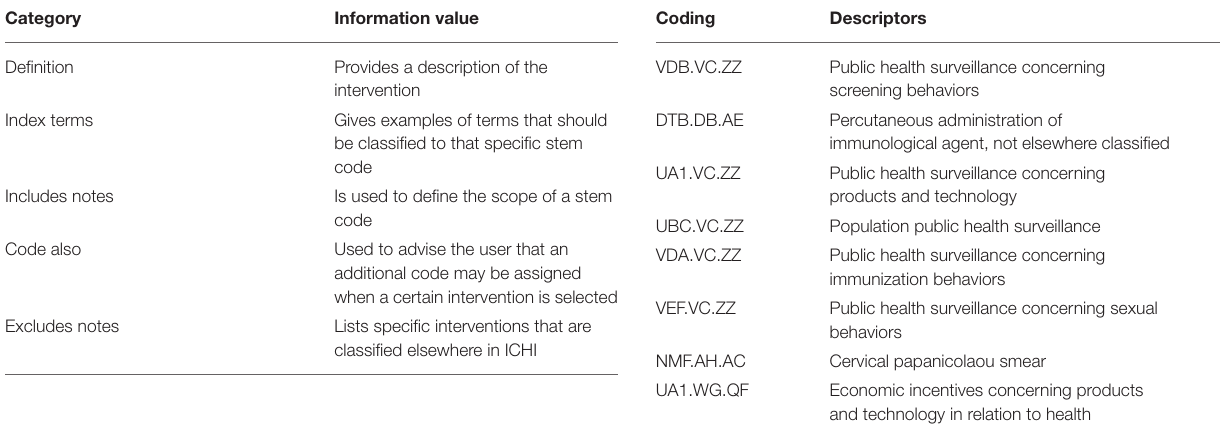
TABLE 1 | ICHI coding information. TABLE 2 | Answers coded with WHO international classification of health